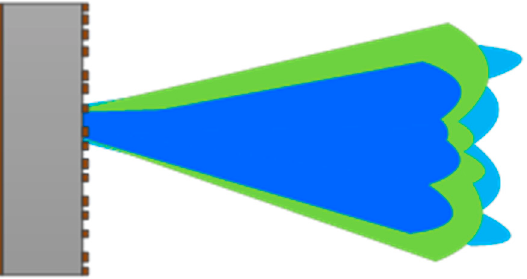
Figure 2. Radiation patterns of metamaterial antenna at different frequency points.